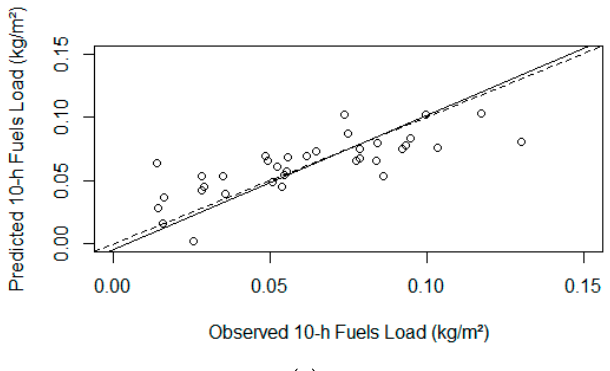
Figure 4. The observed versus predicted plots for the load prediction of the ( a ) total surface fuels (R 2 = 0.71), ( b ) litter (R 2 = 0.69), ( c ) grass/forbs (R 2 = 0.71), ( d ) 1-h (R 2 = 0.59), and ( e ) 10-h (R 2 = 0.6) fuels through the Simulated Annealing (SA) variable selection method and multiple linear regression analysis (the dashed line is the 1:1 line and the solid one is the regression line). These results refer to the models produced with the use of both LiDAR-derived structural and intensity metrics.